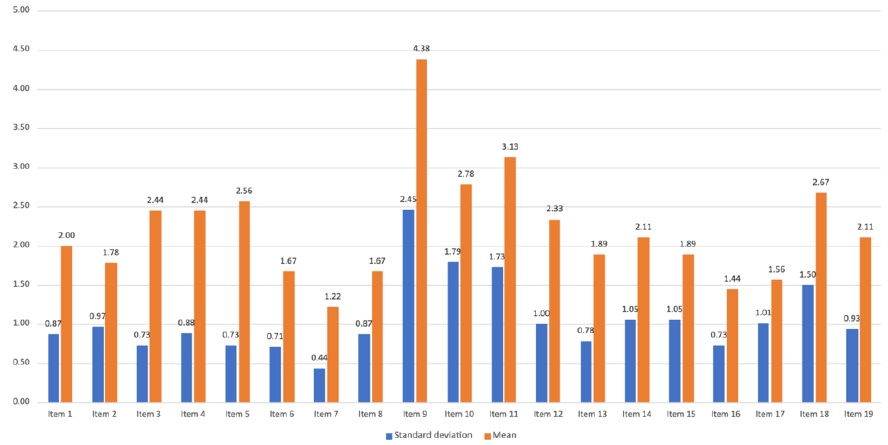
Figure 13. PSSUQ items average scores.